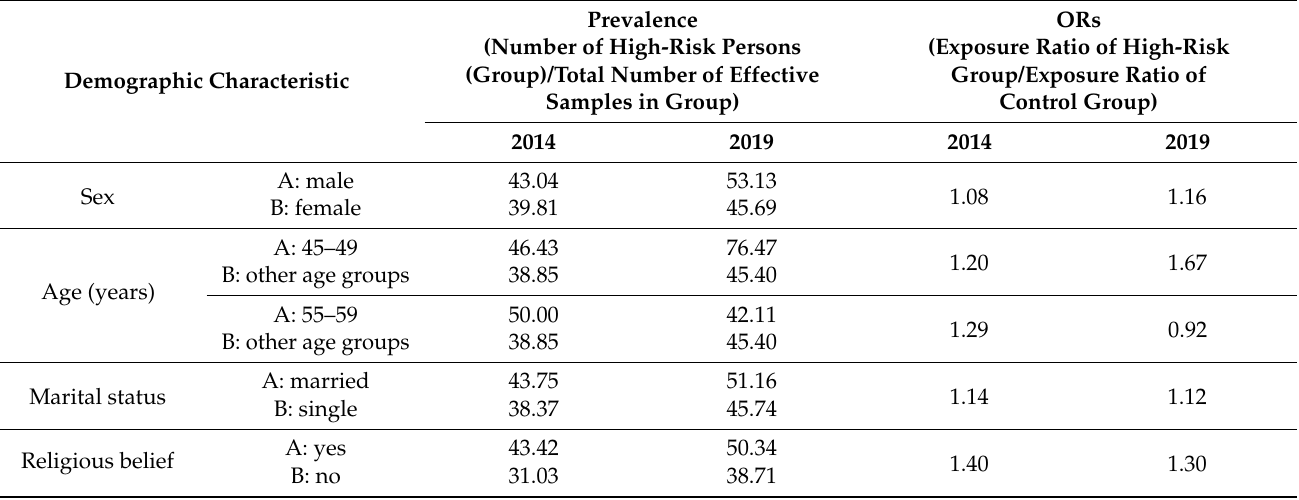
ORs (Exposure Ratio of High-Risk Group/Exposure Ratio